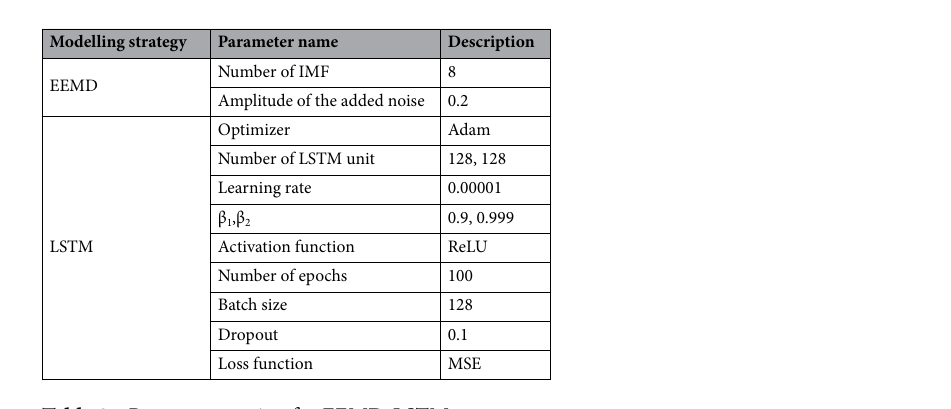
Table 3. Parameter setting for